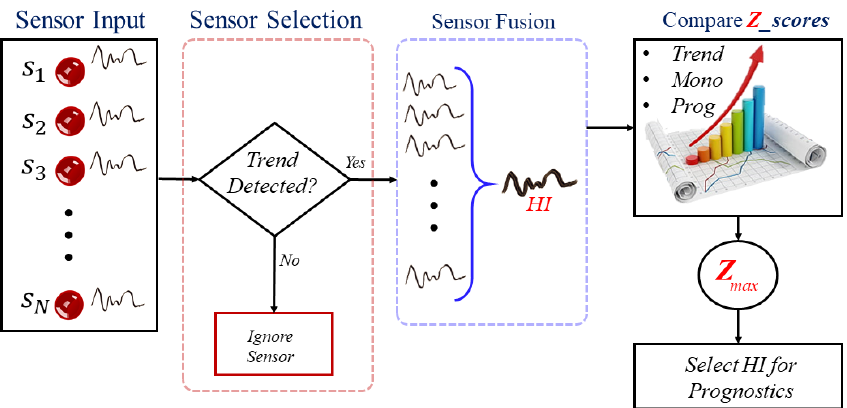
Figure 3. The proposed system model.